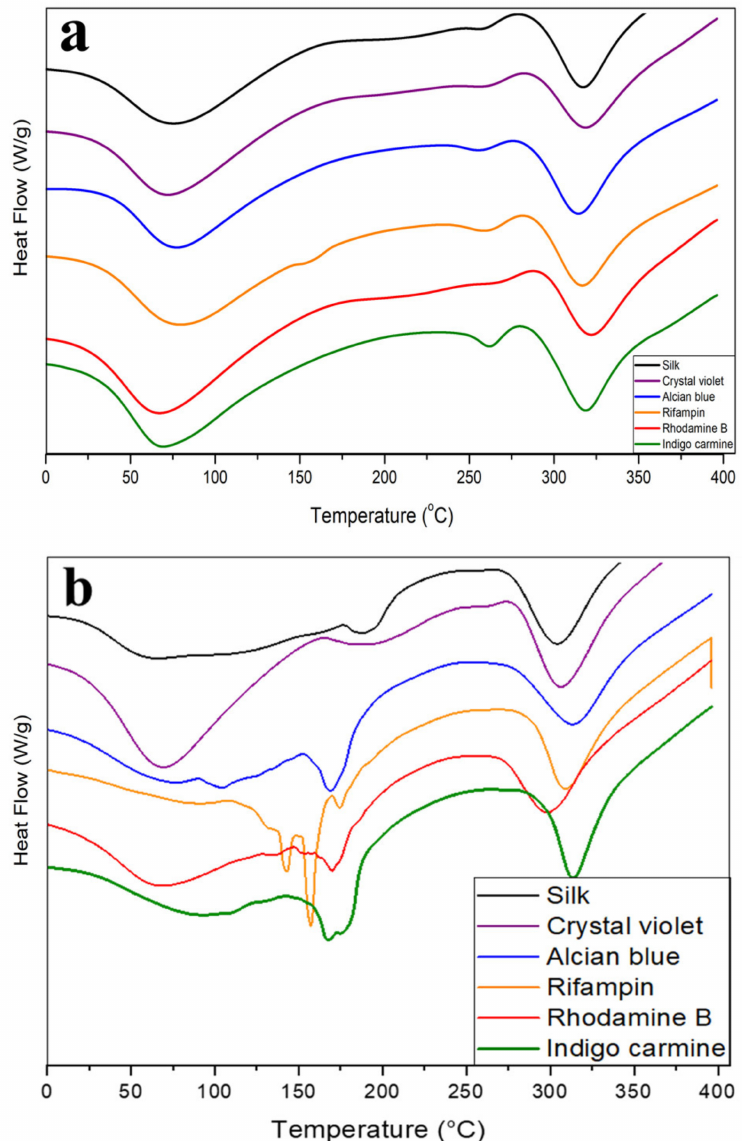
Figure 5. DSC total heat flow thermograms of silk-model drug fibers and films. Total heat flow